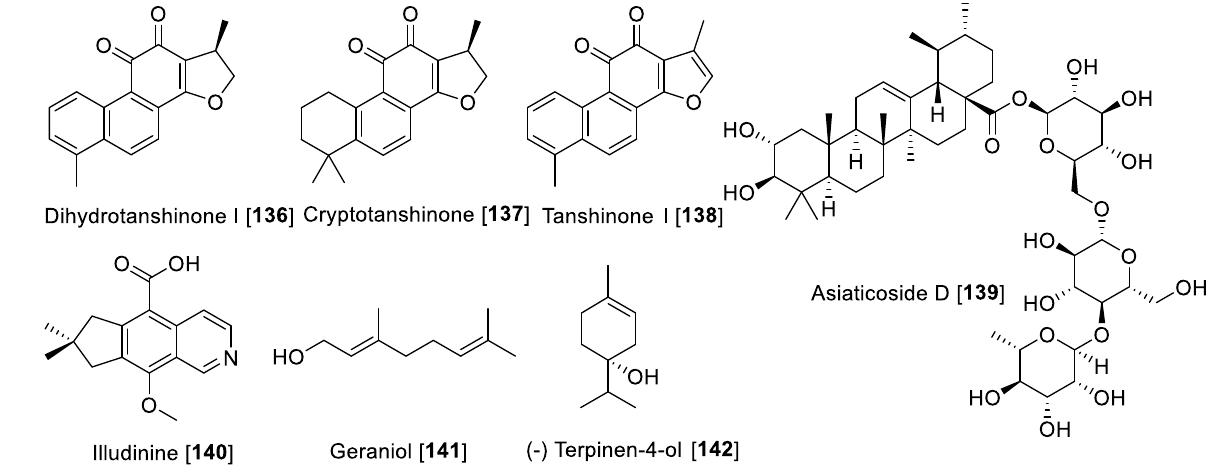
Figure 13. Chemical structure of selected terpenoid MAO inhibitors.